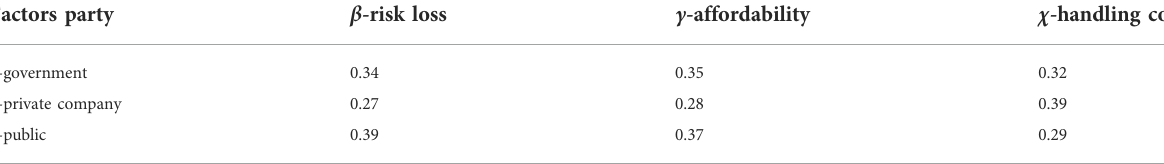
TABLE 4 Sharing willingness score standardization of the government, private company, and public.